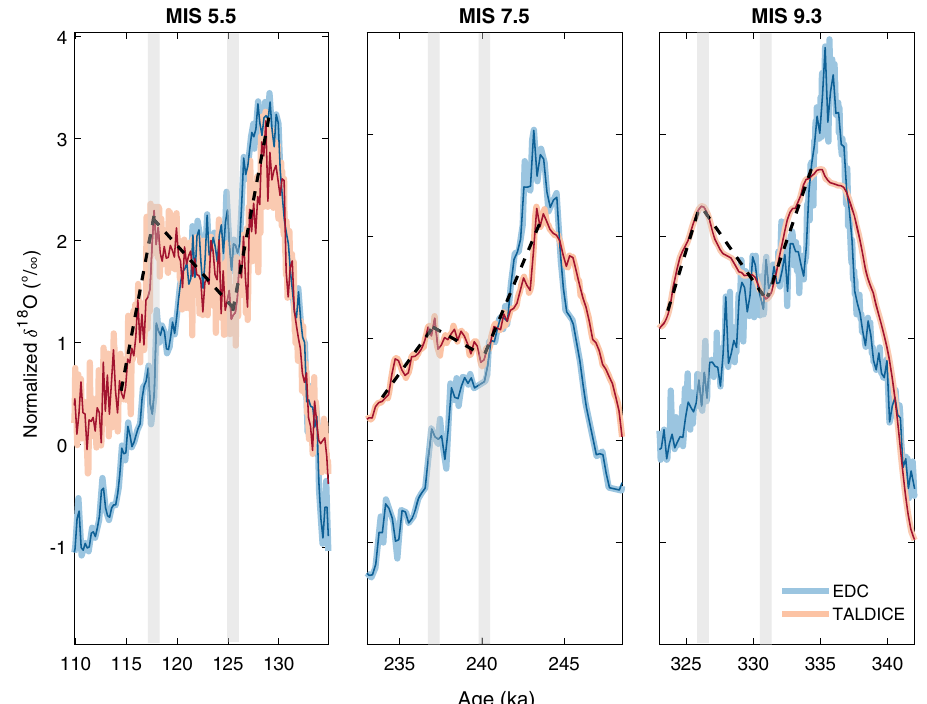
Fig.5|Identi fi cationofchangepointsandanomaliesintheTalosDomeicecore (TALDICE) in comparison to EPICA Dome C ice core (EDC). The original TAL- DICE and EDC δ 18 O records were normalized (pink and light blue, respectively) and thenresampledwitha200yeartimestep(redanddarkblue,respectively).